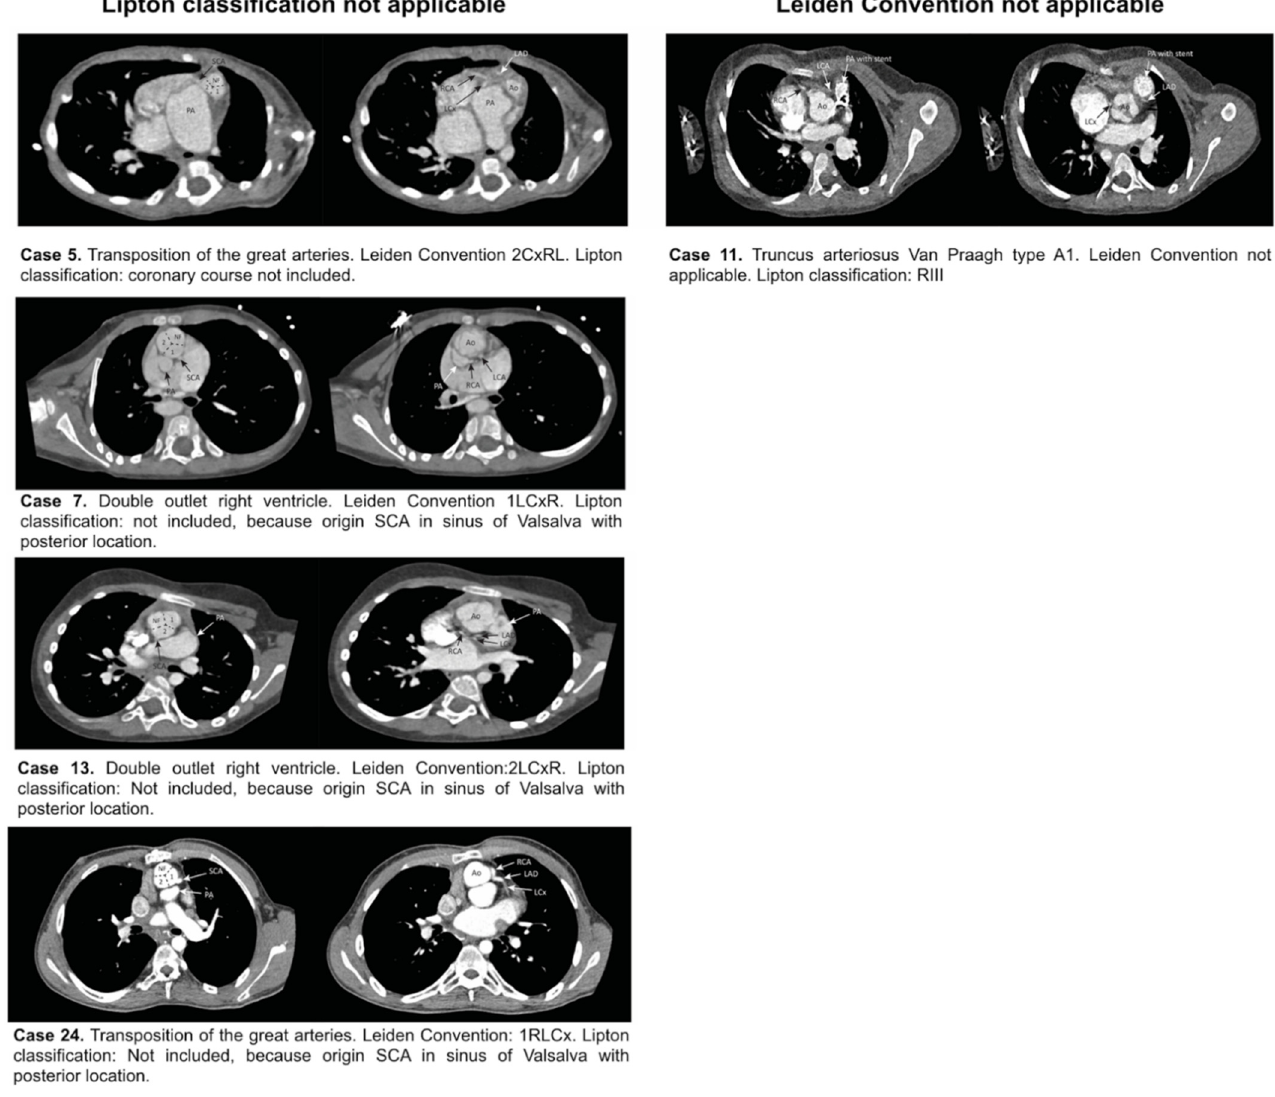
Figure 5. Overview of cases that could be classified only with the Lipton classification or the Leiden Convention. Ao: Aorta. LAD: Left anterior descending coronary artery. LCx: Left circumflex. R: Right. NF: Non-facing sinus. PA: Pulmonary artery. RCA: Right coronary artery. SCA: Single coronary artery. Table 2. Overview of cases not assessable by either classification.